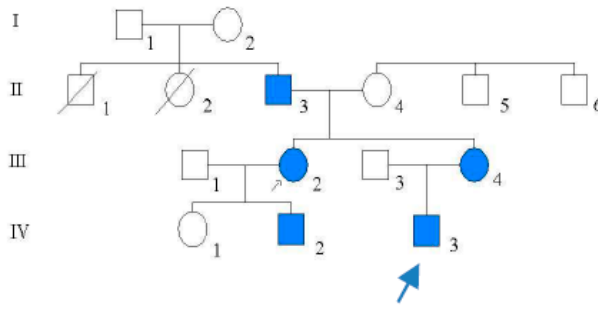
Figure 5. Genealogical tree for Case nos. 2 and 3.